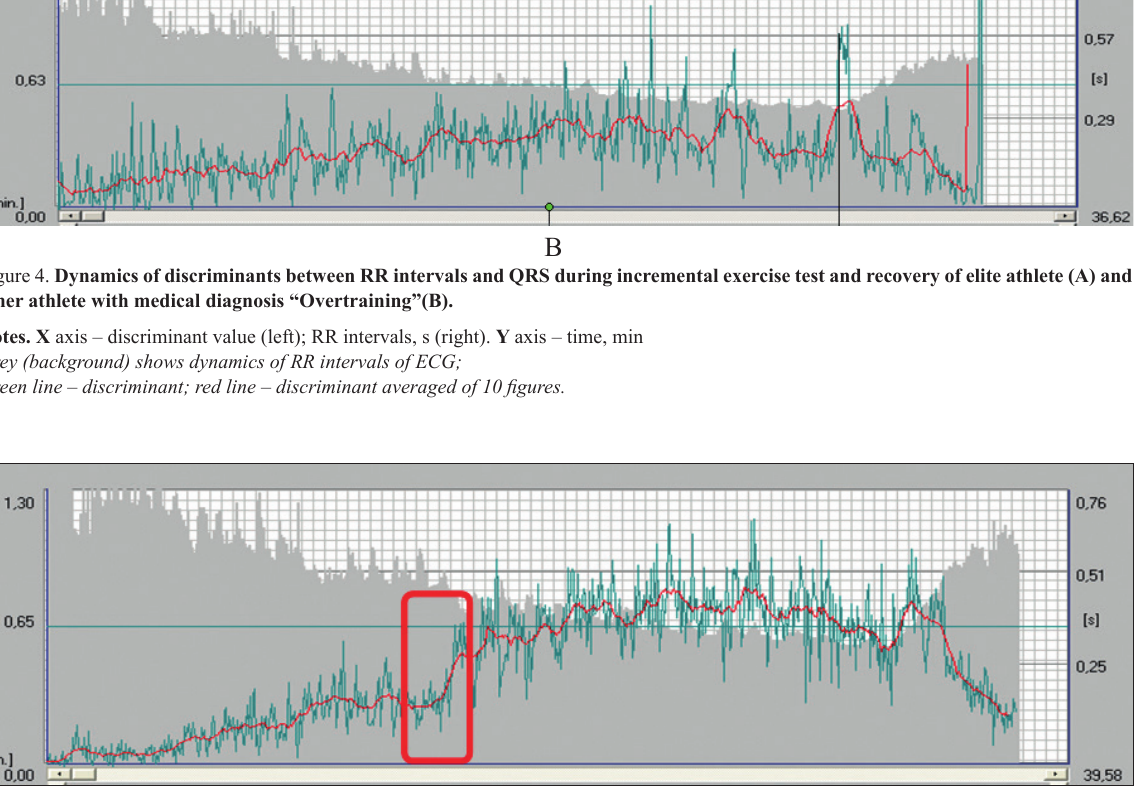
Figure 5. Dynamics of discriminants between amplitude of R wave and RR intervals during incremental exercise test and recovery of elite athlete Notes. X axis – discriminant value (left); RR intervals, s (right). Y axis – time, min Grey (background) shows dynamics of RR intervals of ECG; Green line – discriminant; red line – discriminant averaged of 10